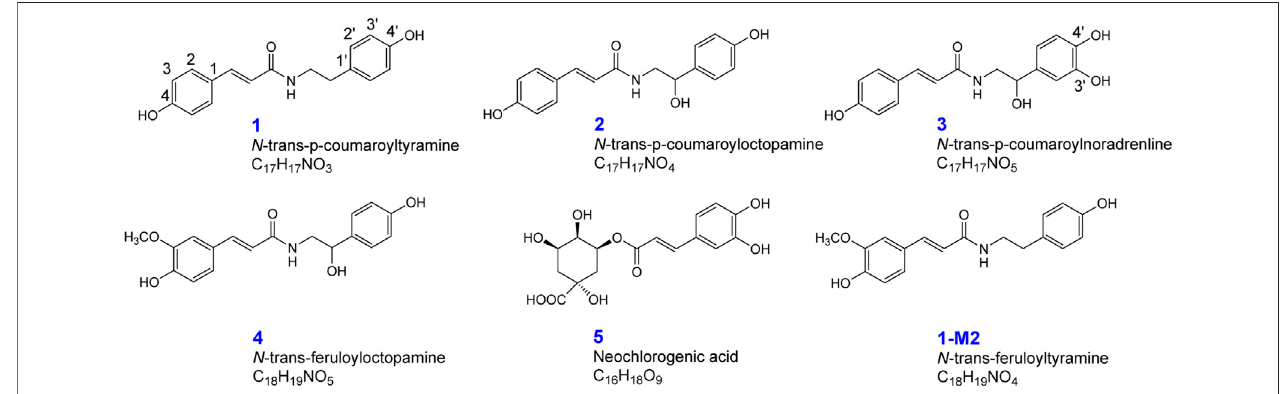
FIGURE 1 | Chemical structures of n -trans- p -coumaroyltyramine ( 1 ), n -trans- p -coumaroyloctopamine ( 2 ), n -trans- p -coumaroylnoradrenline ( 3 ), n -trans- feruloyloctopamine ( 4 ), neochlorogenic acid ( 5 ), and n -trans-feruloyltyramine ( 1-M2 ).